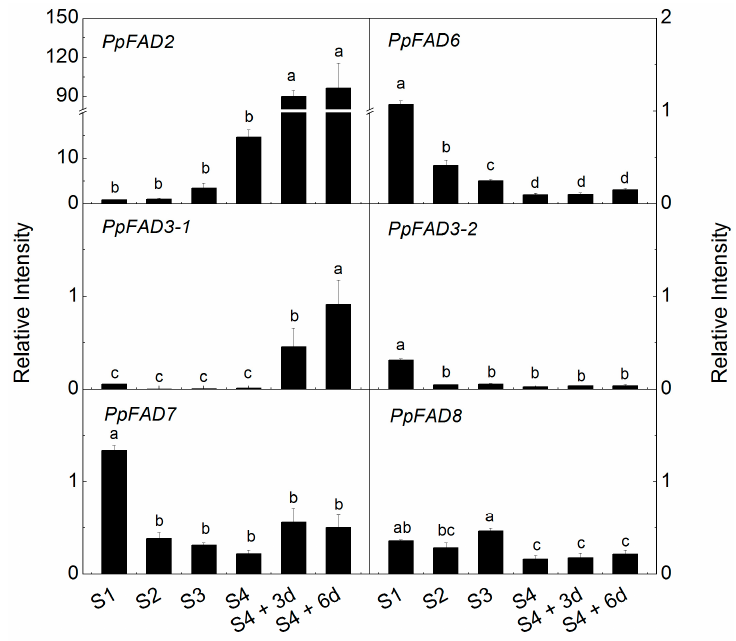
Figure 3. Expression of PpFADs during peach fruit development and ripening. Data are the mean ± stand error from three replicates. Values indicated by different letters represent significant difference at level of 0.05.